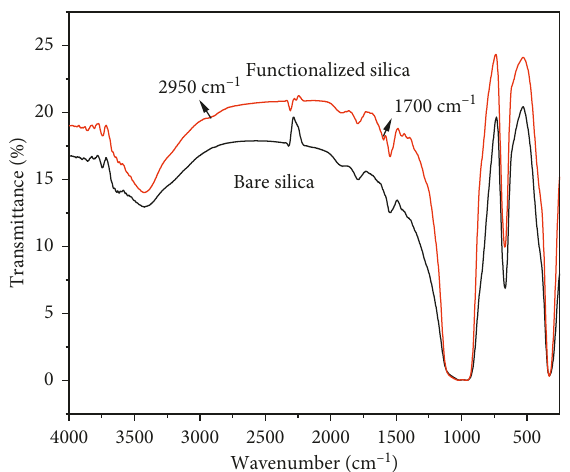
Figure 4: FTIR analysis of functionalized and bare silica nanoparticles.